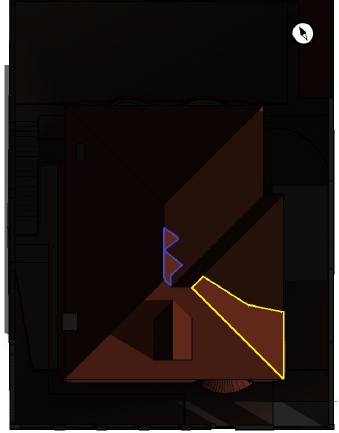
Figure 2. Simulation result of the shading